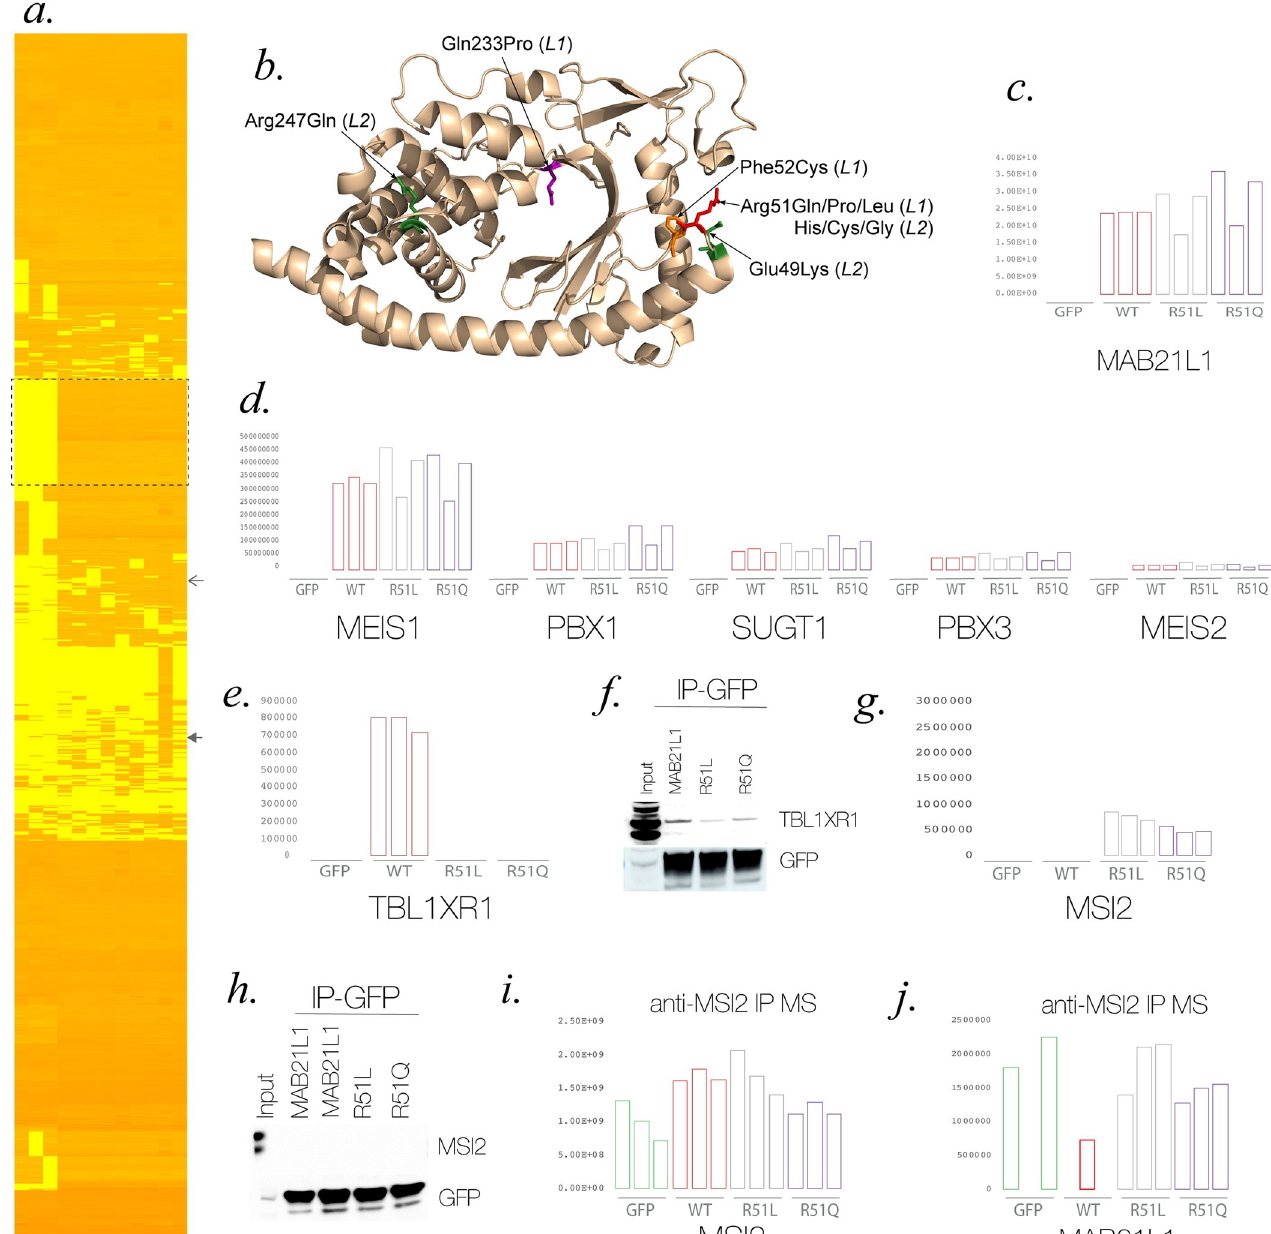
Fig 3. The Effect of disease associated missense variants on protein structure and interactions. A. A heatmap of the log-transformed quantitative mass spectroscopy (MS) results of biological triplicates of anti-GFP immunoprecipitates (IP) of control (GFP), tagged wild-type (WT) and mutant MAB21L1 (R51L and R51Q) from HEK293 cells. B. Representation of the structure of MAB21L1 with the position of the amino acid substitutions seen in MAB21L1 (L1) and MAB21L2 (L2) annotated. C-E Graphs showing the levels of the following classes of proteins in the GFP IP-MS from biological triplicates: C. MAB21L1. D. The five most abundant proteins interacting with WT, R51L and R51Q forms of MAB21L1 (MEIS1, PBX1, SUGT1, PBX3 & MEIS2), the dotted line box indicates the position of this class of protein on the heatmap. E. Wild-type specific interactor (TBL1XR1) and other components of the NCor complex (NCOR & HDAC3), the position in the heatmap is indicated by the closed arrowhead. F. Western blot analysis of the anti-GFP IP using the anti-TBL1XR1 antibody showing differential but not exclusive binding of the wild-type MAB21L1 compared to the mutant forms G. Mutant specific interactor MSI2/ Musashi-2), the position in the heatmap is indicated by the open arrowhead. H. Western blot analysis of the anti-GFP IP using the anti-MSI2 antibody was unable to detect interaction with wild-type or mutant forms of MAB21L1 I-J. anti-MSI2 IP-MS analysis I. MSI2-derived peptides were present in all replicates and cell-lines in the anti-MSI2 IP J. MAB21L1-derived peptides were detectable in all replicates of the mutant forms of MAB21L1 but in only one replicate for the wild-type. Surprisingly peptides derived from endogenous MAB21L1 were detectable in two of the three GFP-only biological replicates.